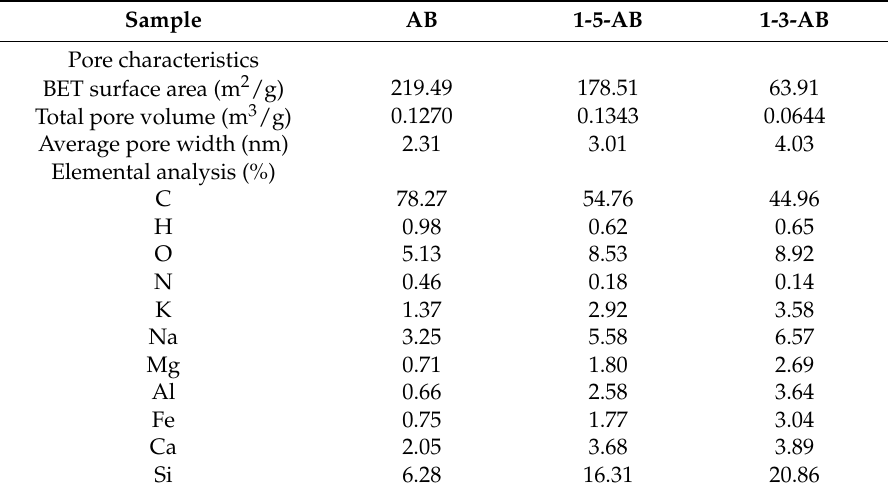
Table 2. Basic physical–chemical properties of AB, 1-5-AB, and